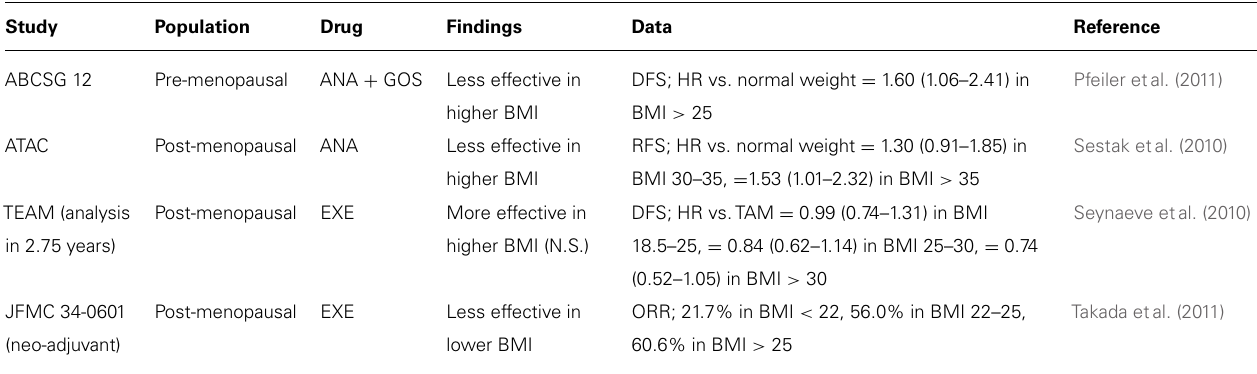
Table 1 | Body mass index (BMI) and outcome in clinical trial with aromatase inhibitor.